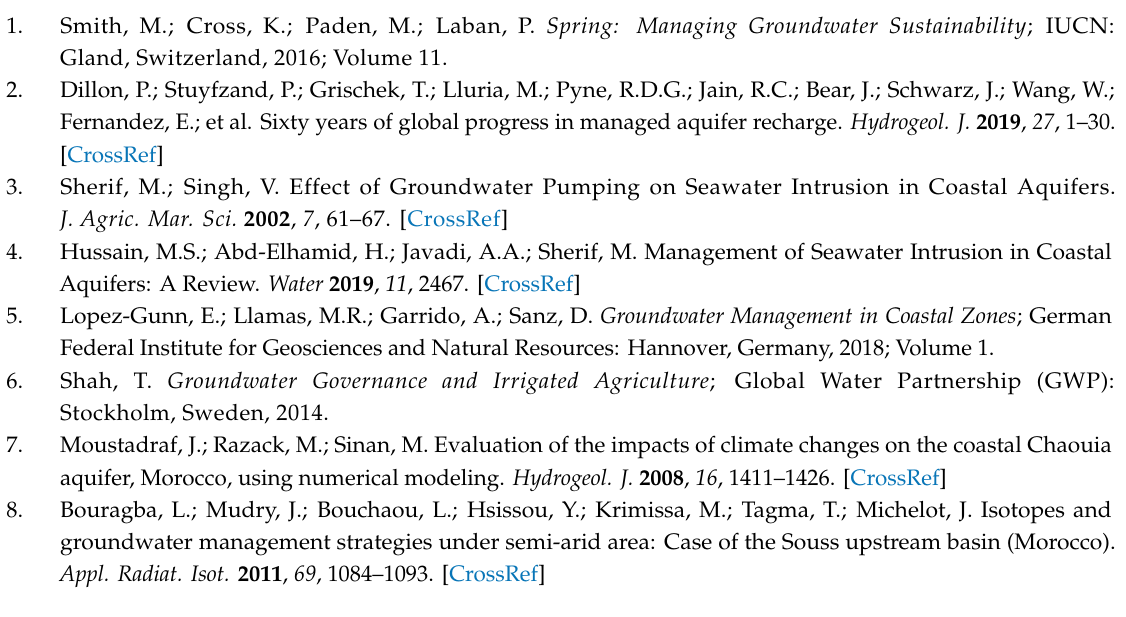
Table S1: Calculated Saturation Indices of the Analyzed Samples (2015, 2017, 2018, 2019), Table S2: Physicochemical Parameters of the Analyzed Samples from the Plio-Quaternary Aquifer (2015, 2017, 2018 and 2019). Author Contributions: Conceptualization, M.O., M.B., D.J.M. and D.O.; methodology: M.O., M.B. and